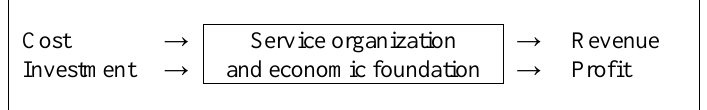
Fig. 2. The input/output of DEA